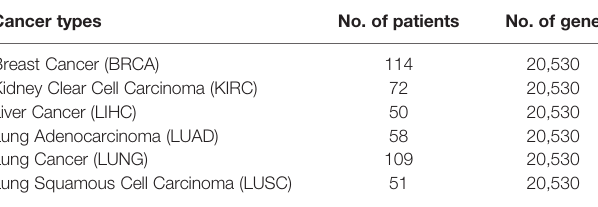
TABLE 1 | Six binary-class RNA-seq